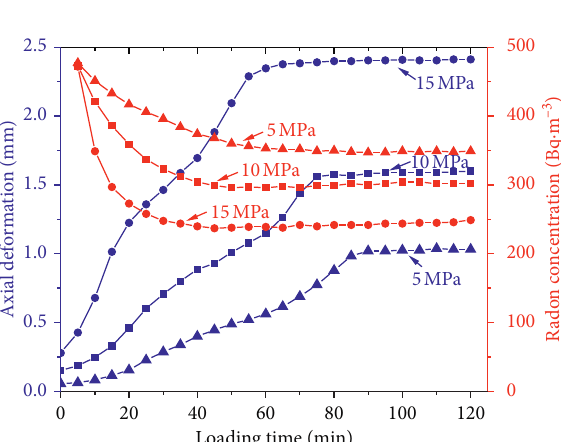
Figure 9: The gradient of different UCL.